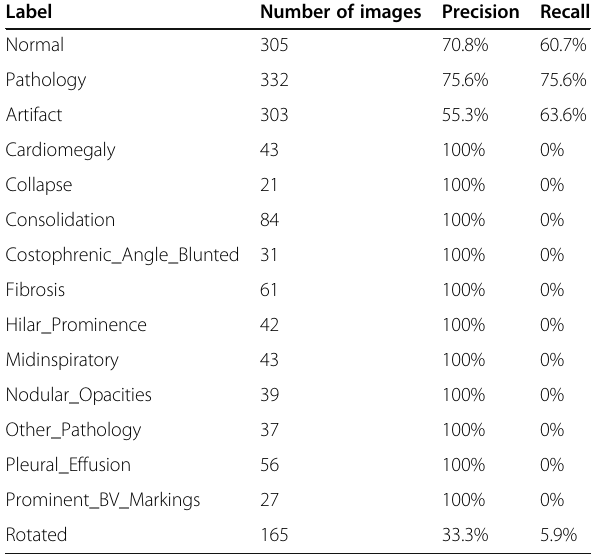
Table 1 Accuracy